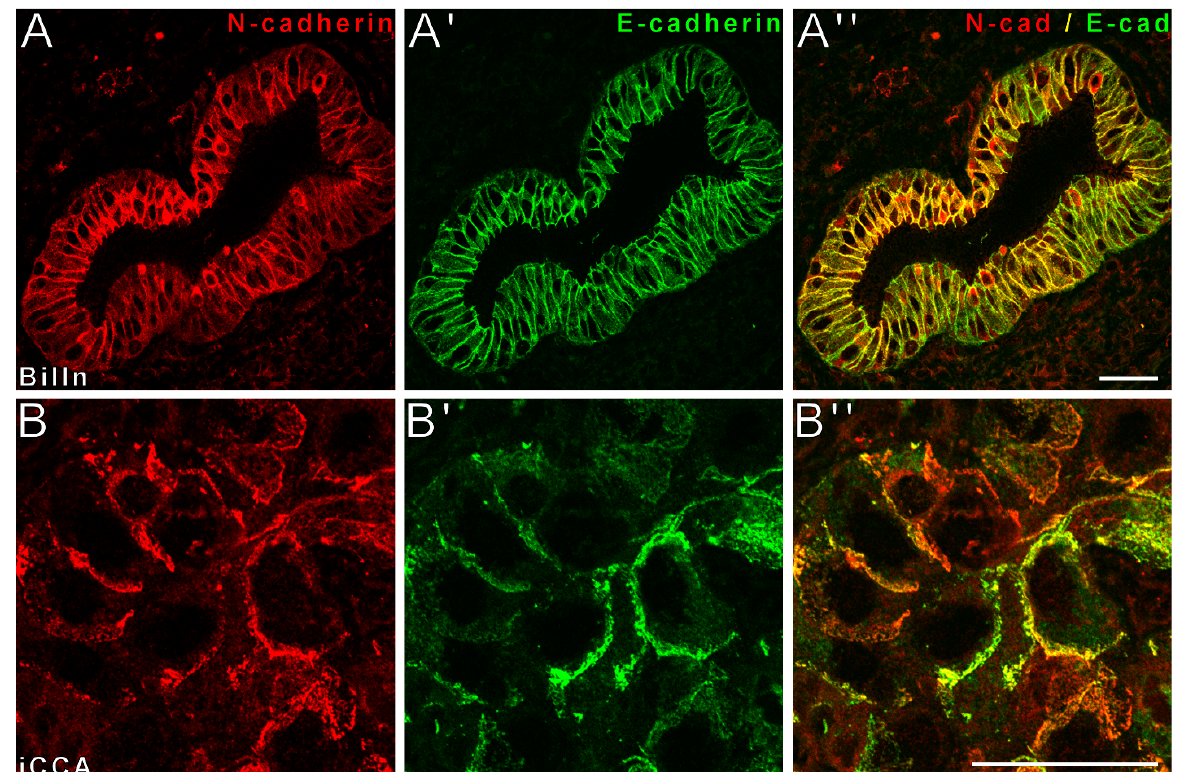
Figure 3. E ‐ and N ‐ cadherin are retained in human BilIN ‐ lesions as well as in iCCA. Double ‐ label laser scanning immunofluorescence microscopy shows partial colocalization of E ‐ cadherin (E ‐ cad, Alexa 488, green) and N ‐ cadherin (N ‐ cad, cy3, red) in BilIN ‐ lesions ( A – A’’ ) as well as in poorly differentiated iCCA ( B – B’’ ). Besides complete colocalization, as demonstrated by the merged yellow color, the cell membrane also stretches with more N ‐ cadherin or more E ‐ cadherin, as seen. Bar length: 20 μ